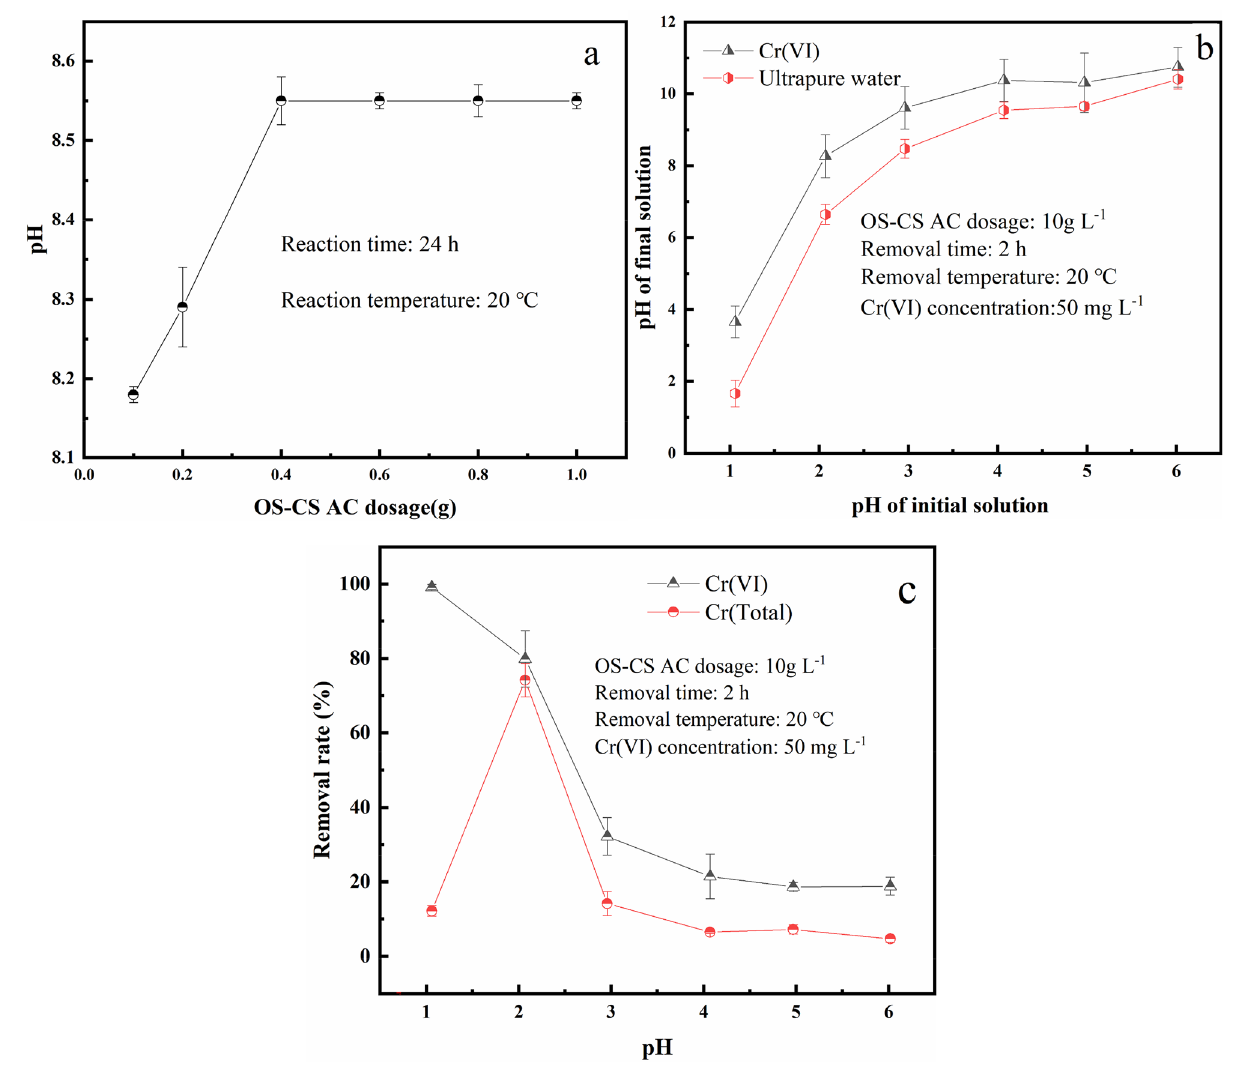
Figure 1. The effect of pH on the surface charge of OS-CS AC ( a ), The effect of OS-CS AC to pH of simulated wastewater and ultrapure water ( b ), The effect of pH to removal rate of Cr(VI) and Cr(Total) ( c